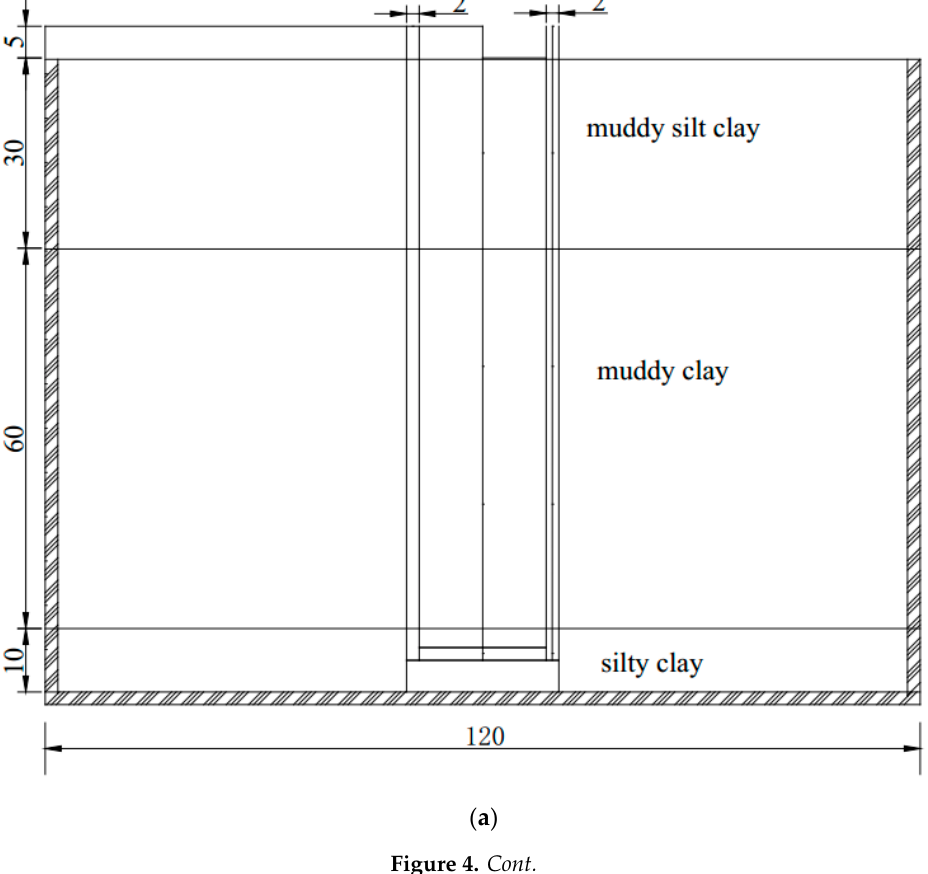
( b ) Figure 4. Experimental model box: ( a ) model soils distribution; ( b ) sensors.